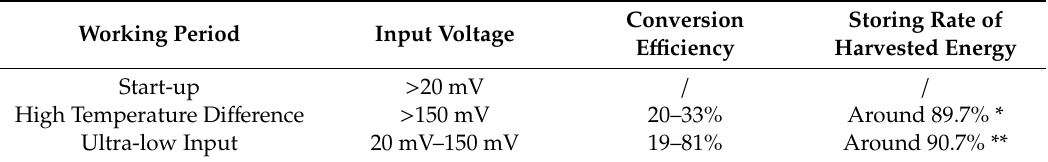
Table 3. Operating features of proposed